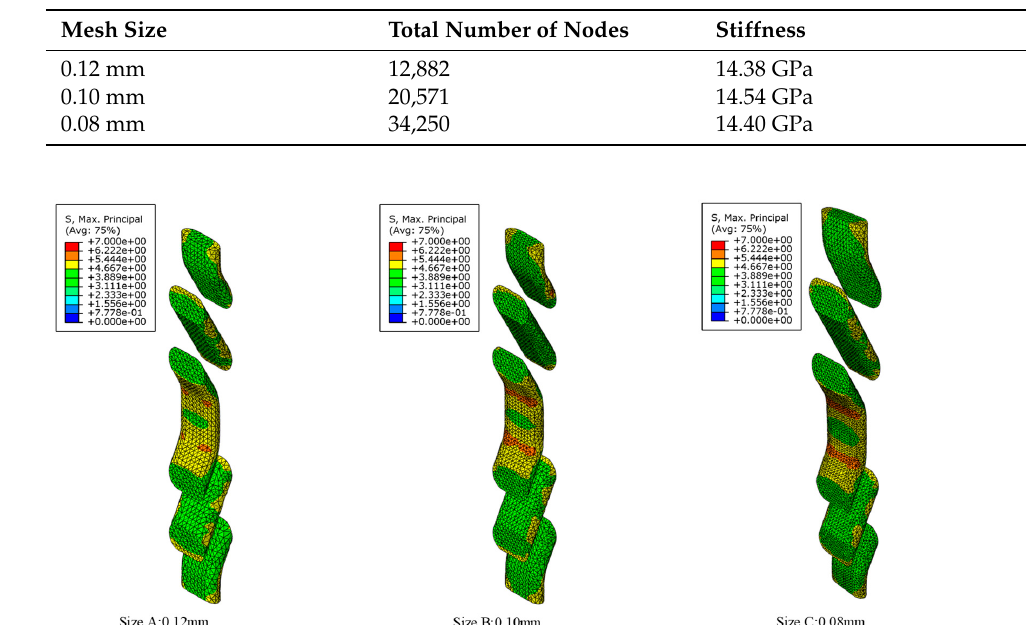
Figure A2. Comparison of maximum principal stress contours for warp yarns at a loading strain of 0.013% in the mesh convergence study.